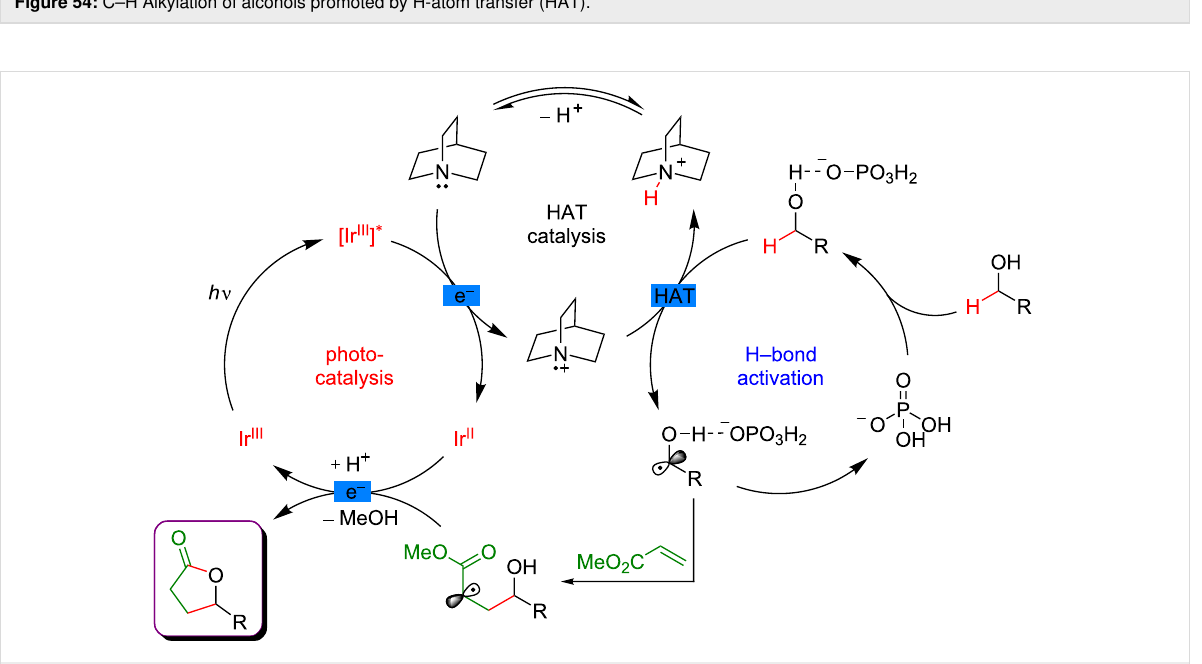
Figure 55: Proposed mechanism for the C–H alkylation of alcohols promoted by